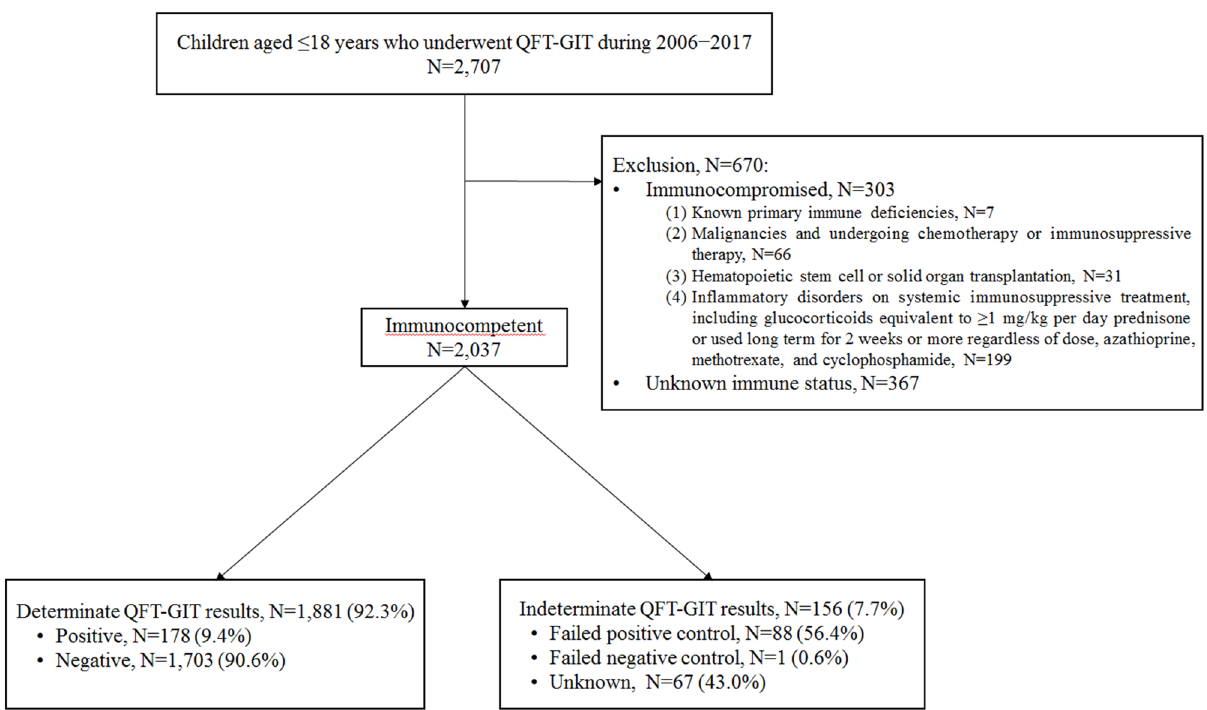
Figure 1. Flow chart presenting the protocol for inclusion in the present study. QFT-GIT QuantiFERON-TB Gold